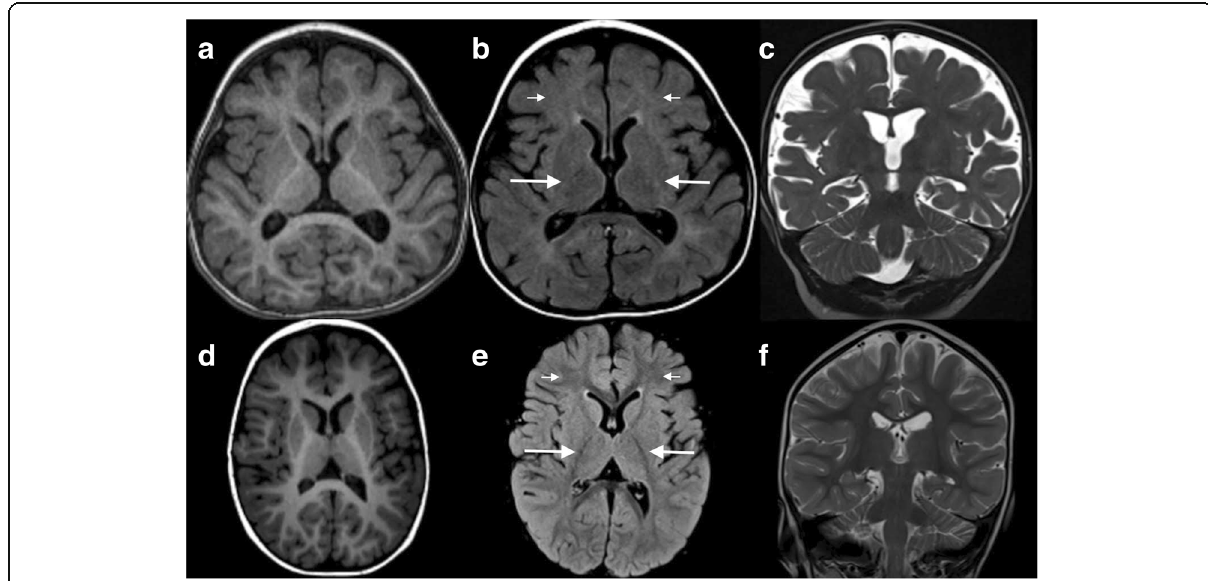
Fig. 1 Brain MRI. a - c : SLC35A2-CDG patient at 22 months. d - f : Normal age and sex matched patient for comparison. a , d T1-weighted axial images, b , e TurboFLAIR axial images, c , f T2-weighted coronal images. Images a and b demonstrate mild widening of the cerebral sulci that is most notable in the frontal and temporal lobes. Shortening of the head in the anterior-posterior dimension (brachycephaly) was noted,